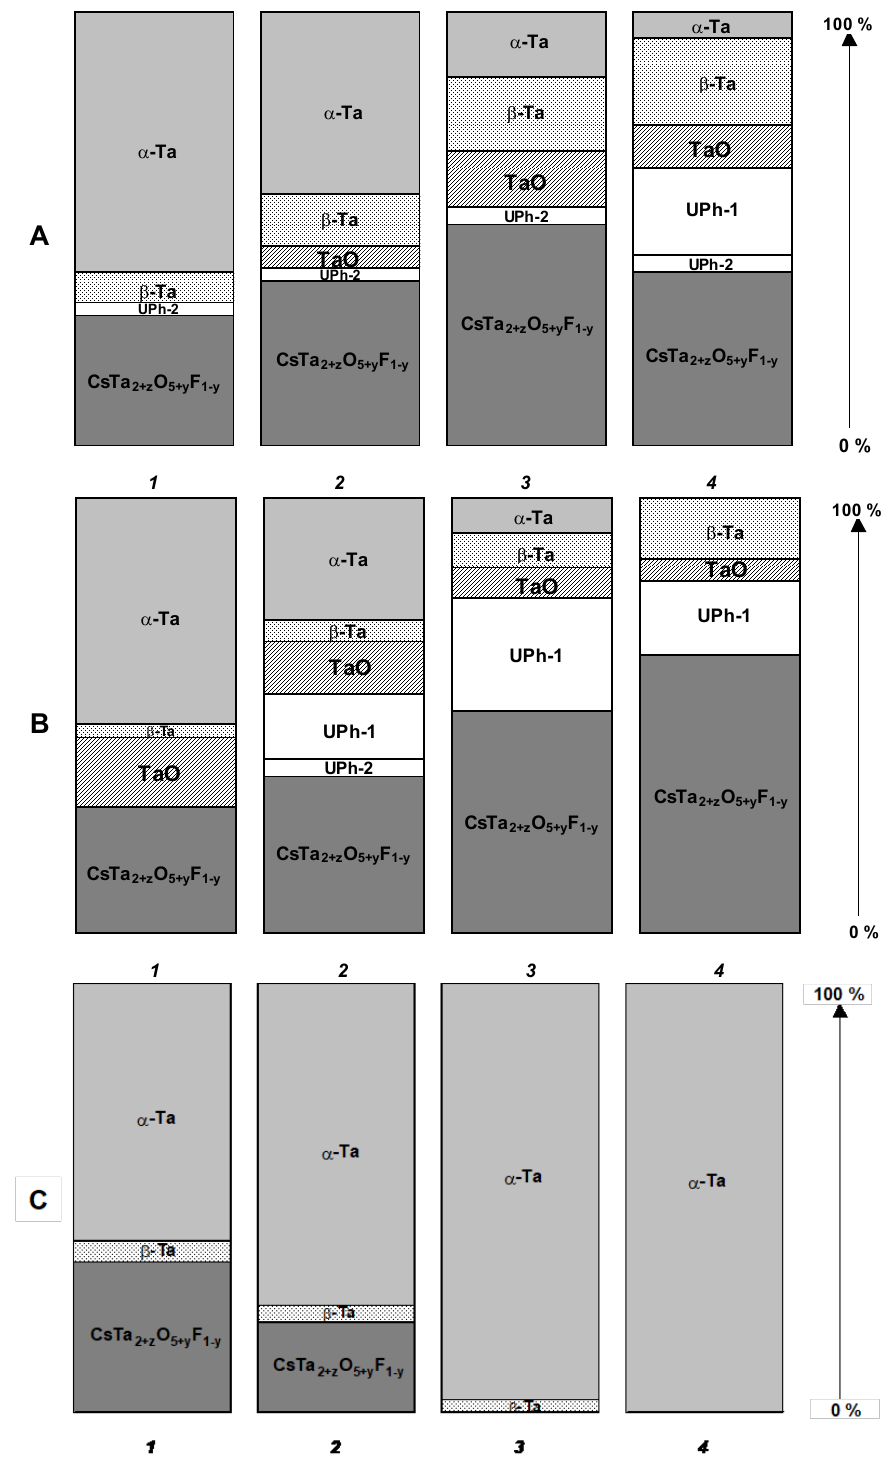
Figure 19. Diagrams of the phase composition of the cathodic products deposited at a current density of 0.15 A cm − 2 at ( A ) 923 K, ( B ) 1023 K, ( C ) 1173 K. The concentration of K 3 TaOF 6 in the CsCl melt was ( 1 ) 1.25, ( 2 ) 2.5, ( 3 ) 5.0, and ( 4 ) 10.0